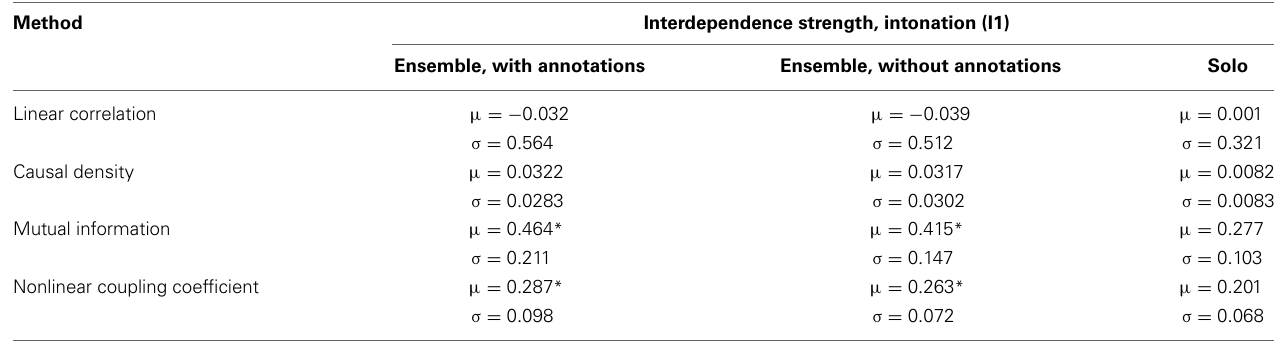
Nonlinear coupling